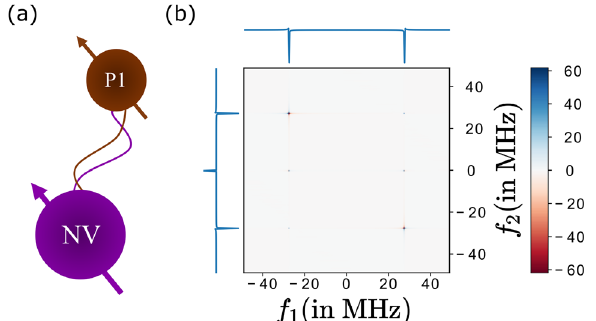
Figure 3. ( a ) Schematic of NV coupled to a nearby electron spin of P1 defect center. ( b ) PrePSy applied on a single NV with a single P1 defect center in its proximity. Parameters chosen are B r 1.2nm 8 lattice points away and at an angle of 0 ◦ | | = =